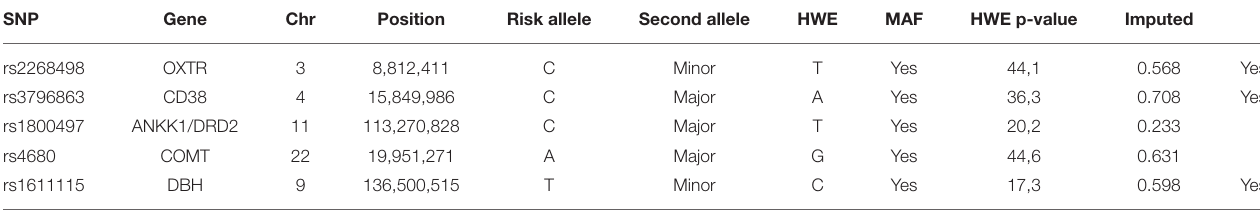
TABLE 2 | Single-nucleotide polymorphisms (SNP) in the oxytocin and dopamine signaling pathways known to be functional in humans. SNP Gene